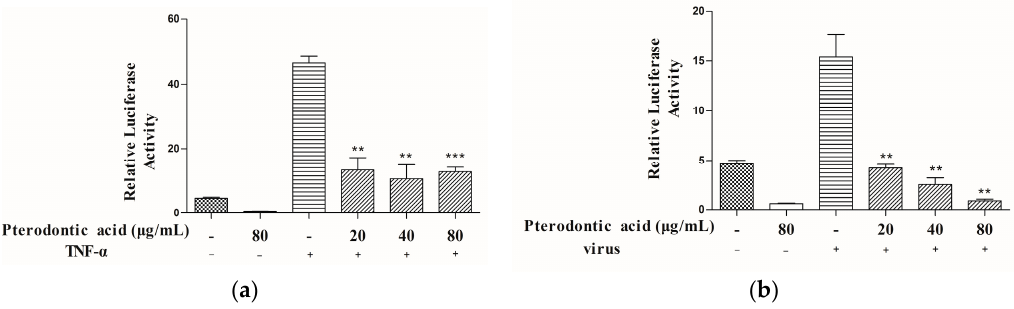
Figure 4. Effects of pterodontic acid on TNF- α and influenza virus-induced activation of NF- κ B pathway. HEK293 cells were stably transfected with NF- κ B luciferase reporter plasmid. ( a ) The cells were stimulated with 20 ng/mL TNF- α in the presence or absence of different concentration of pterodontic acid for 24 h; ( b ) The cells were stimulated with influenza A virus (MOI = 0.1) in the presence or absence of different concentration of pterodontic acid for 24 h. After extraction of protein from HEK293 cells, the expression of NF- κ B was assayed through luciferase activity. ** p < 0.01; *** p < 0.001, relative to TNF- α or virus control.